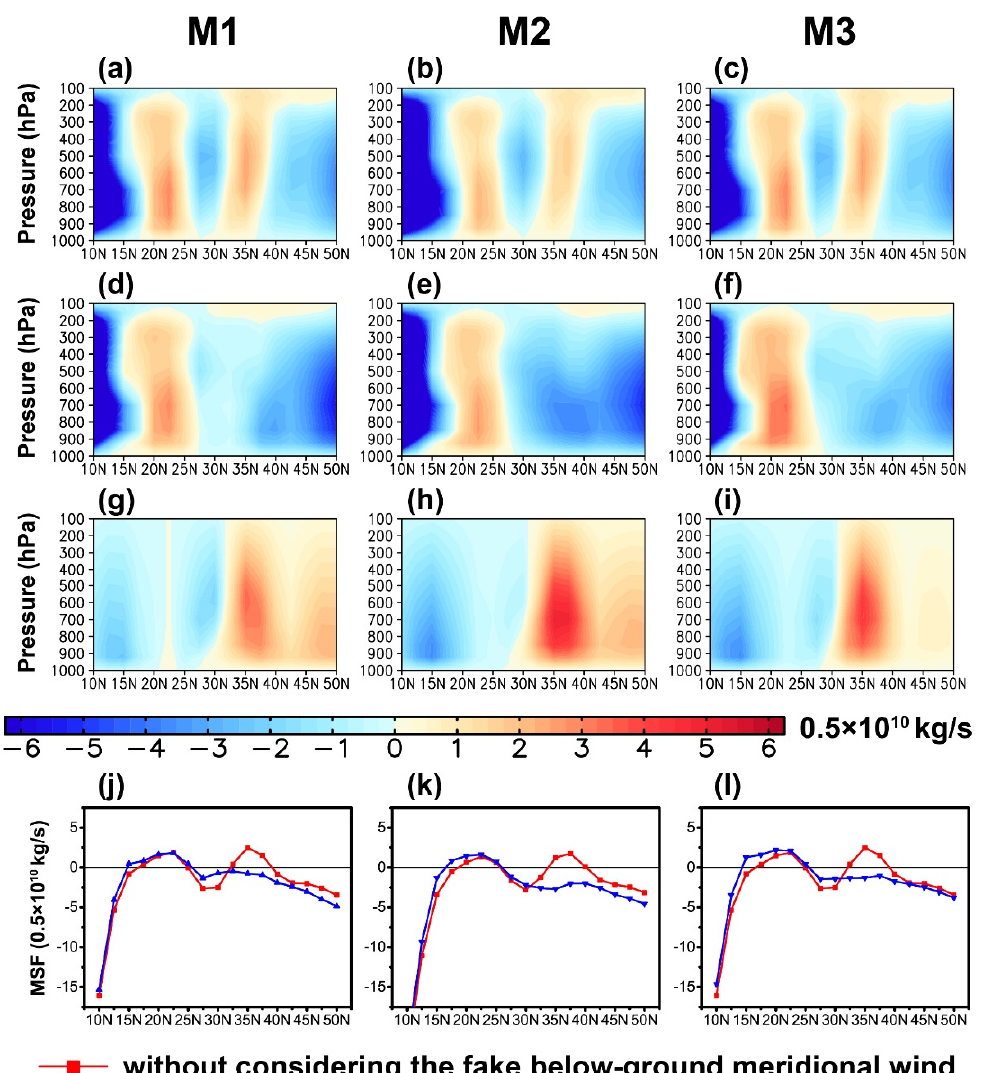
Figure 1. ( a – c ) Northern Hemisphere ( NH) Hadley circulation (HC) between 10° N and 50° N in July 1979 represented by the mass stream function (MSF) derived from the ( a ) traditional method (M1), ( b ) local partitioning method (M2), and ( c ) three-pattern decomposition of global atmospheric circulation (3P-DGAC, M3) without considering fake below-ground meridional wind (FBGMW) using the National Centers for Environmental Prediction (NCEP)/Department of Energy (DOE) Reanalysis (hereafter NCEP2) data sets. ( d – f ) Same as ( a – c ) but for the NH HC represented by the MSF that considers FBGMW. ( g – i ) Same as ( a – c ) but for the difference between the uncorrected and corrected NH HC. ( j – l ) Latitudinal distribution of the MSF between 10° N and 50° N at 500 hPa in July 1979 derived from ( j ) M1, ( k ) M2, and ( l ) M3. The red and blue lines represent the latitudinal distribution of the MSF without and with considering FBGMW, respectively. The units for the MSF are 0.5 × 10 10 kg/s.